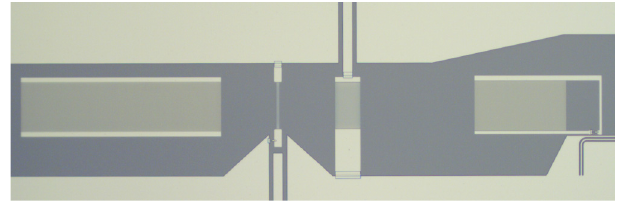
FIG. 5. Device B . The sample used for the multimode entan- glement measurements presented in Sec.